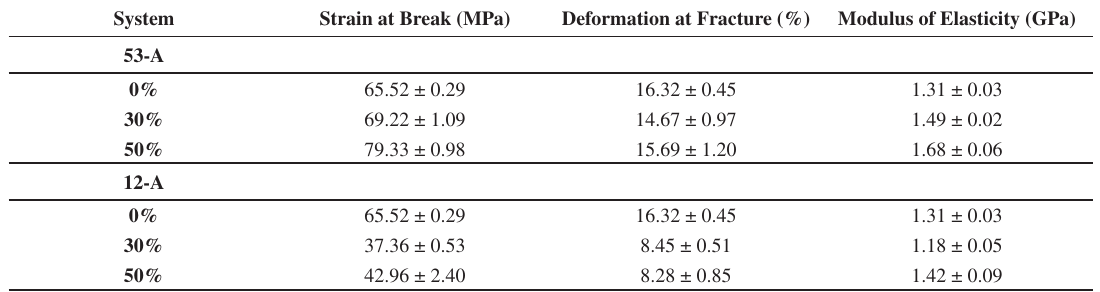
Table 7. Results of the mechanical compression test.